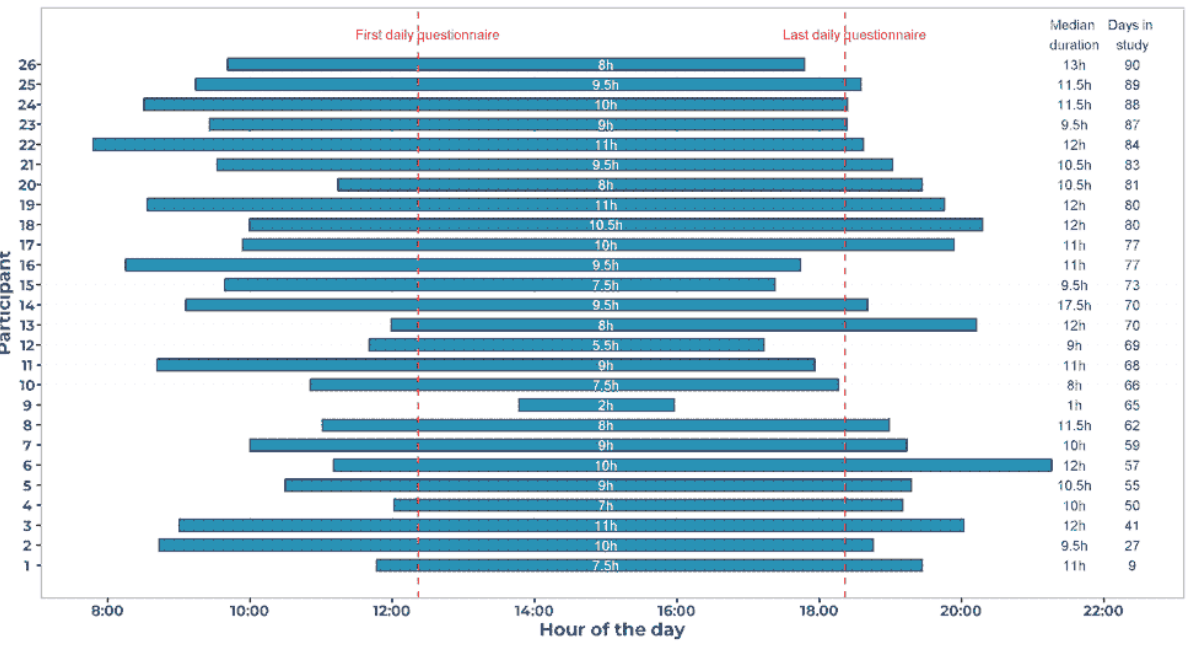
Figure 3. Average duration of continuous sensor data collection, per participant. Each bar corresponds to a participant. The bar starts at the average time of day that sensor data collection started and ends at the average time of day that sensor data collection ceased (duration in hours shown in middle of bar). On the right: the median wear time and number of days the participant was active. Median wear time can be higher than clock time duration of the longest wearing episode, as some participants recharged the watch and put it on multiple times.